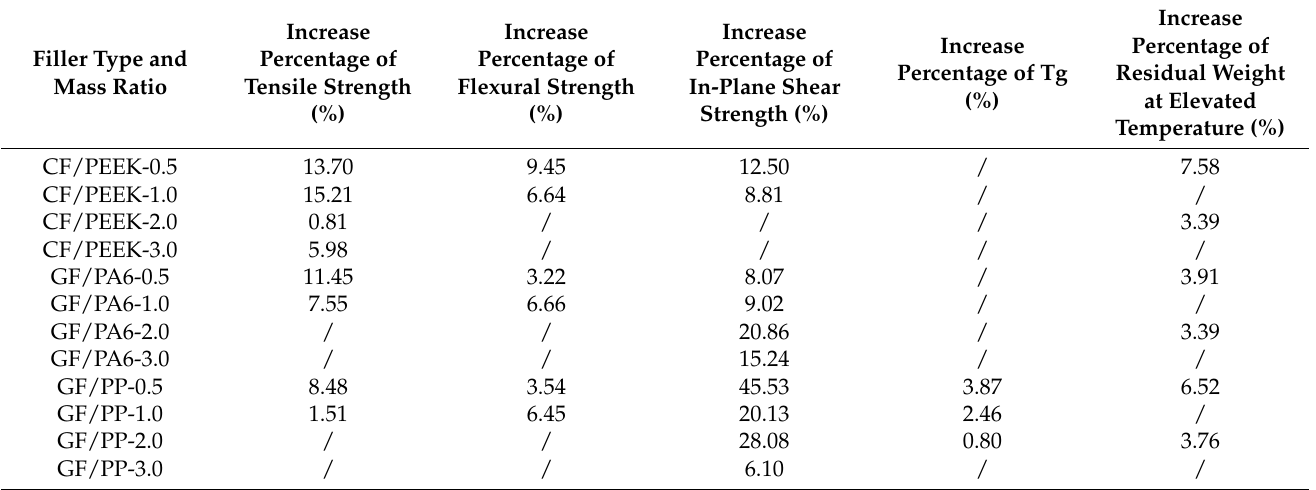
Table 4. Proportioning design of optimal composite filler and the improvement percentage of mechanical and thermal